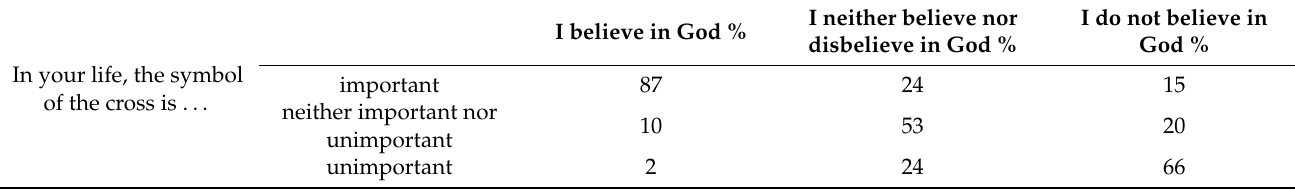
Table 2. Declaration of faith and the importance of the cross in everyday life.